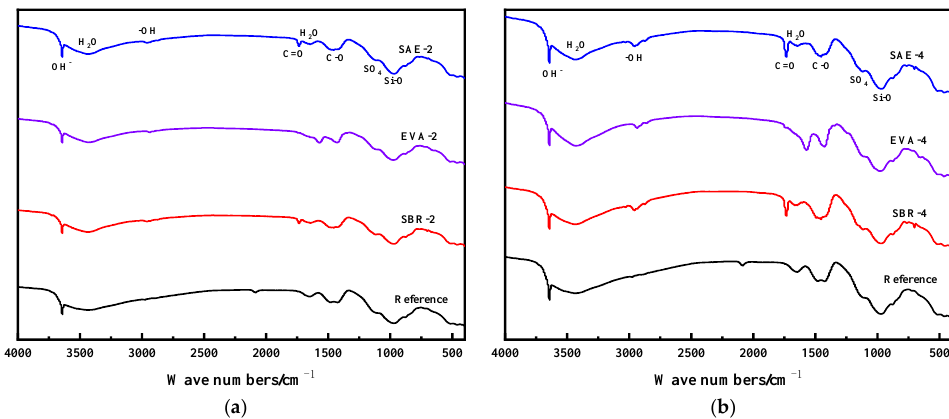
Figure 8. FTIR curves of paste samples with different polymer latex types and contents at 28 days: ( a ) polymer–cement ratio is 6%; ( b ) polymer–cement ratio is 12%.